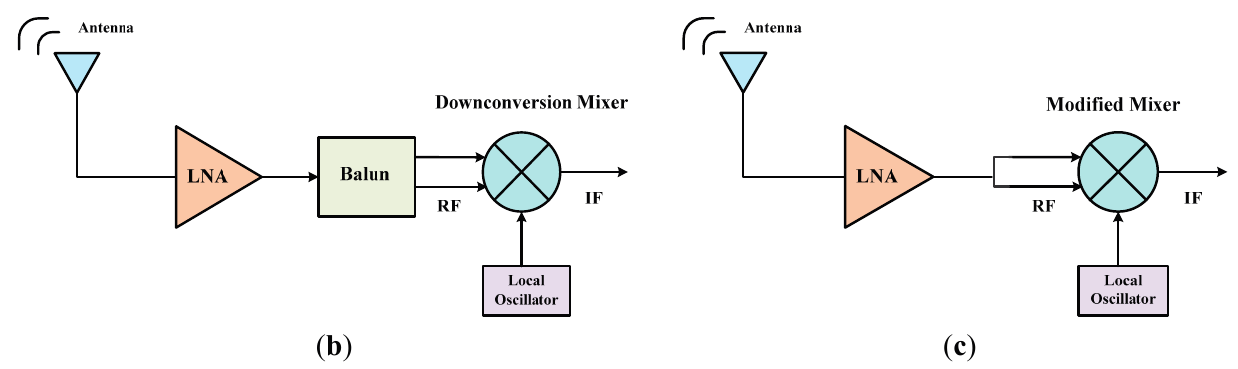
Figure 1. ( a ) Block diagram of a simple narrowband receiver; ( b ) Receiver front-end with LNA, balun and mixer; ( c ) Proposed balunless receiver